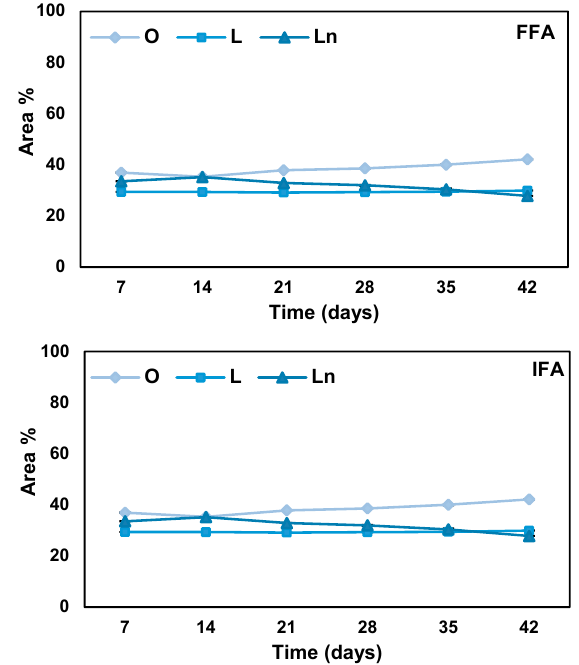
Figure 7. Fatty acid composition (area percentage, mean value ± SD) of FFA and IFA series during the thermal treatment.